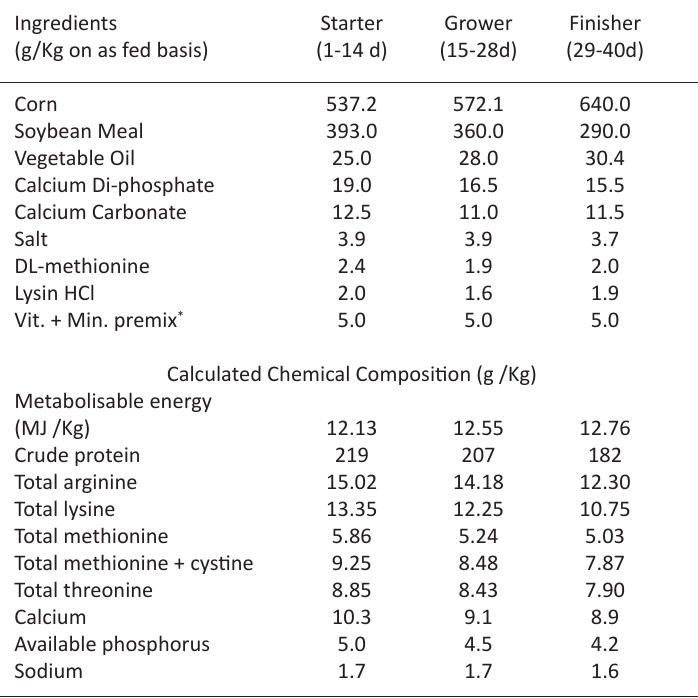
* Each kg of the vitamin and mineral supplied: Vitamin A (retinyl acetate, 13000 IU); Vitamin D3 (cholecalciferol, 4000 IU); Vitamin E (DL- α -tocopheryl acetate, 80 IU); Vitamin K (menadione sodium bisulfite, 3 mg); Riboflavin (6.0 mg); Pantothenic acid (6.0 mg); Niacin, (20 mg); Pyridoxine (2 mg); Folic acid (0.5 mg); Biotin (0.10 mg); Thiamine (2.5 mg); Vitamin B (90 mg); Fe(30 mg); Cu (10 mg); I (1.5 mg); Se (0.2 mg); ethoxyquin (100